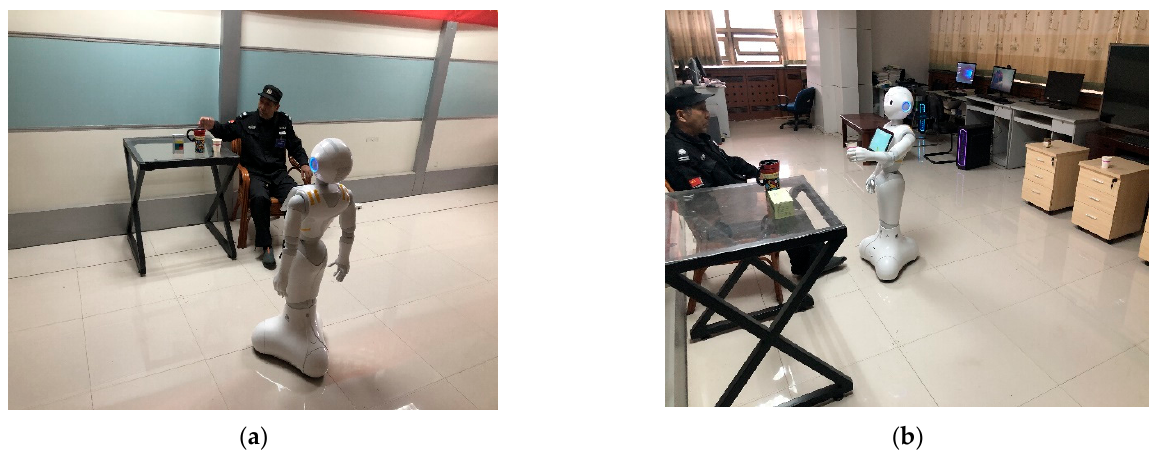
Figure 7. Experimental scene. ( a ): middle-aged and old people are making gestures; ( b ): the robot is executing the corresponding command.